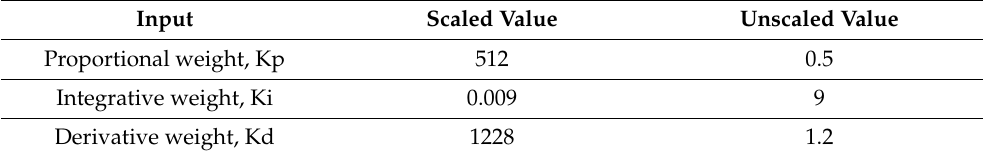
Table 5. PID Controller